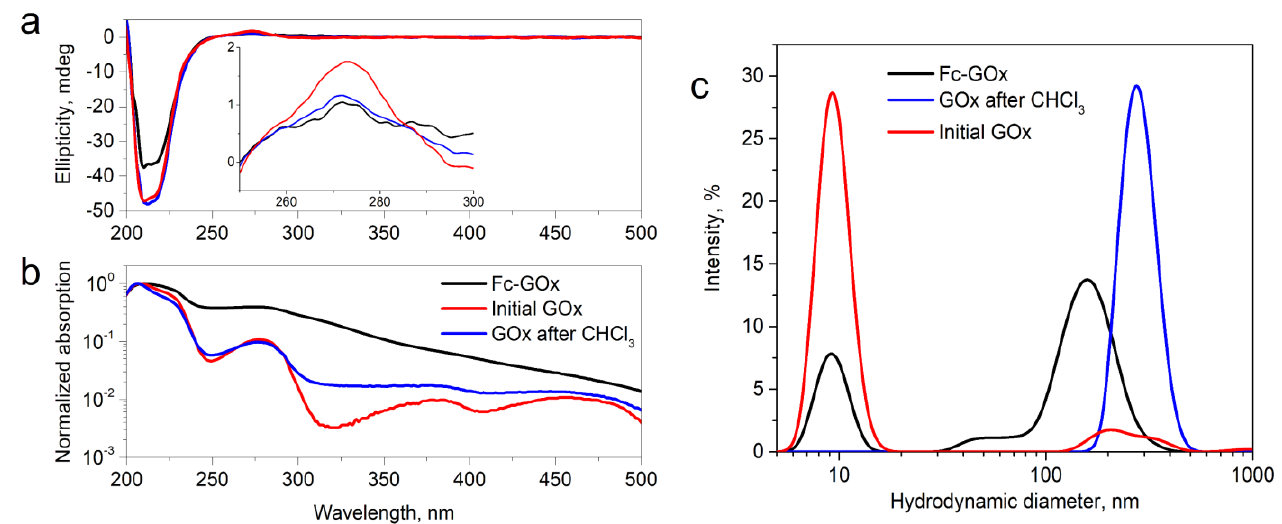
Figure 1. Spectroscopic characterization of Fc-GOx: ( a ) CD spectra of the Fc-GOx, unaffected (initial) GOx and GOx after its exposure in CHCl 3 samples (c = 1 mg mL − 1 ) and ( b ) UV–Vis (c = 0.25 mg mL − 1 ); ( c ) the measured hydrodynamic diameters of Fc-GOx, initial GOx, and GOx after its exposure in CHCl 3 (c = 1 mg mL − 1 ). All the samples were dissolved in the PPB pH 7.0 solution. Based on the observation from the UV–Vis spectrum that the enzyme can aggregate to nanoparticles, hydrodynamic diameters of the Fc-GOx, unaffected GOx, GOx after CHCl 3 samples in the buffer solution were measured using a dynamic light scattering (DLS) method. Figure 1c shows that particles with diameters of 10 nm and a small fraction with a diameter of ~200 nm were recorded for the unaffected GOx in the buffer solution.